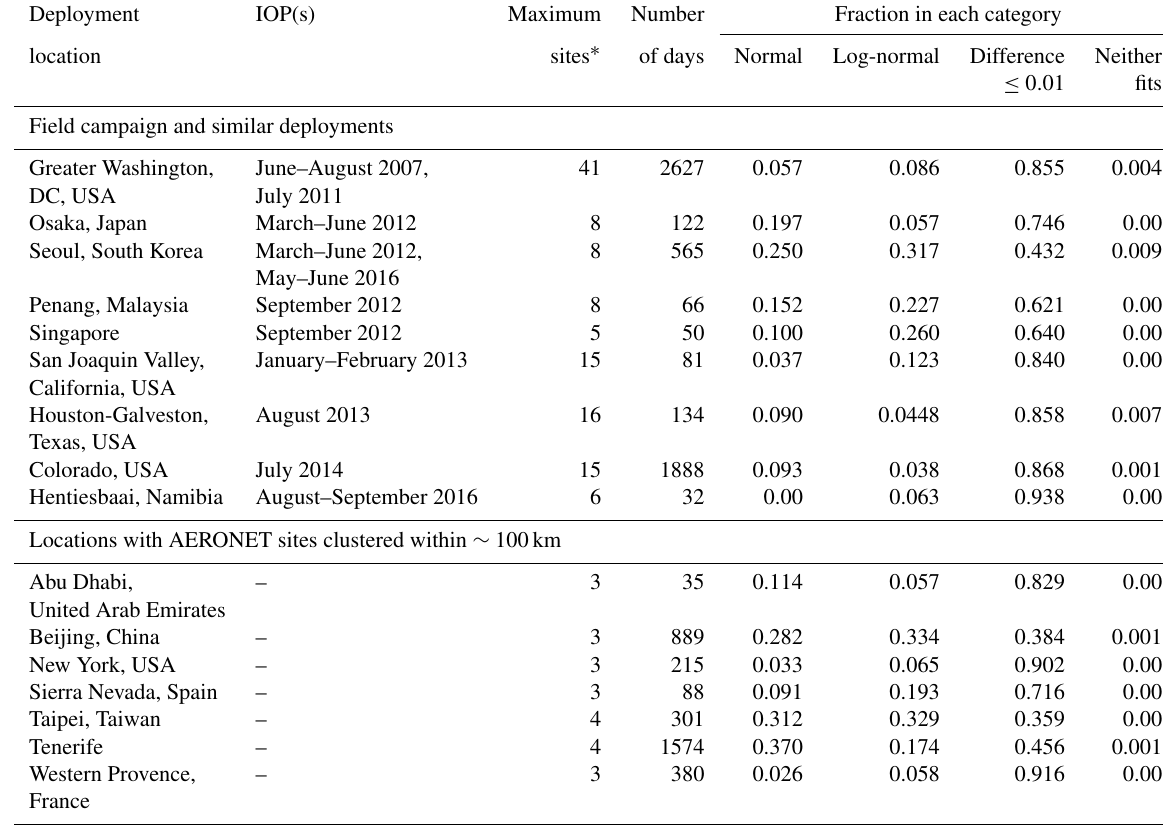
Table 2. Fractional SW test assignment of spatial AOD variation with a day from selected AERONET DRAGON-like deployments and clustered sites. IOP(s) Maximum Number Fraction in each category sites ∗ of days Normal Log-normal Difference Neither ≤ 0 .